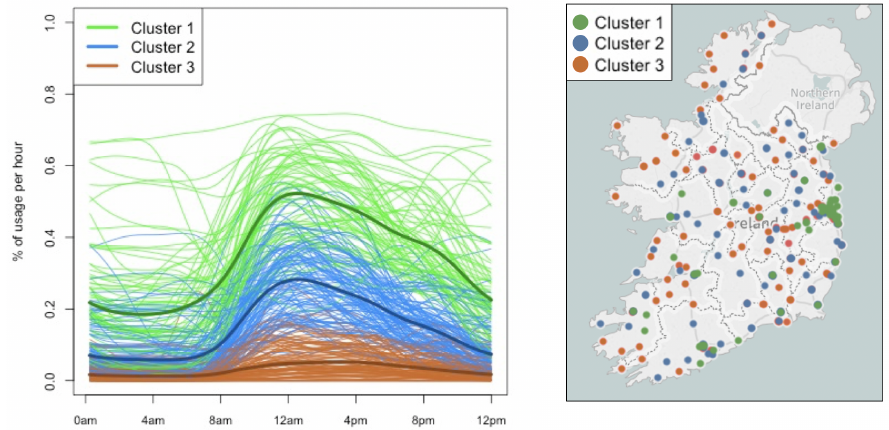
Figure 14. Functional clustering for Standard Type 2 charging points and relative position on the map